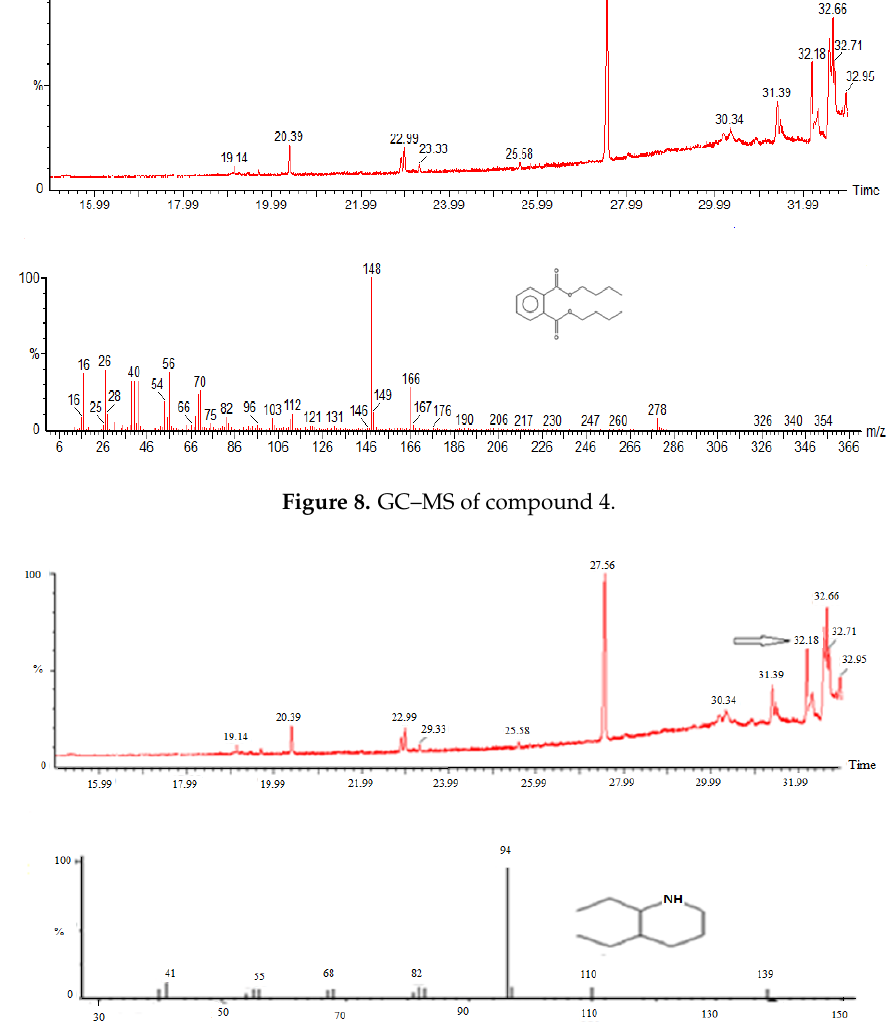
Figure 9. GC–MS of compound 7.